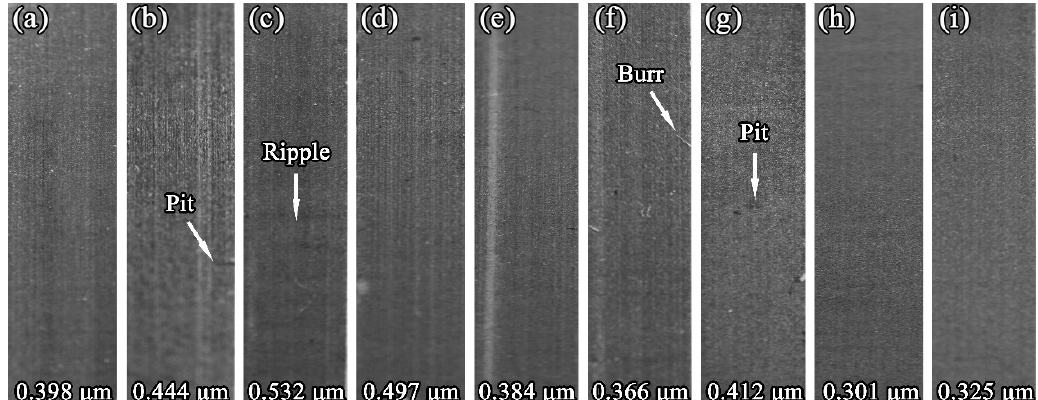
Figure 5. Damage morphology of the machined surfaces (the cutting conditions of a – i are consistent with the No. 1 ‐ 9 in Table 6).